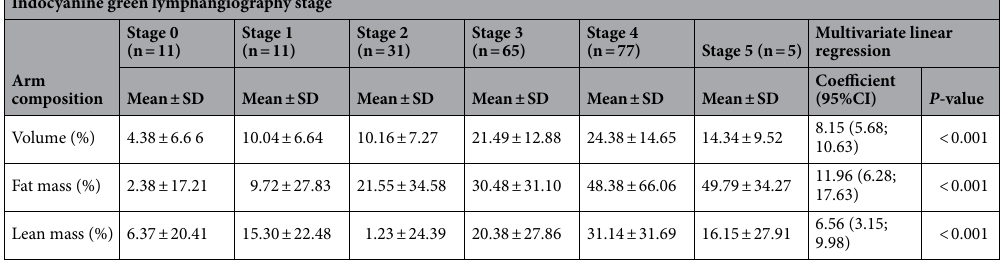
Table 3. Indocyanine green lymphangiography stage and excess volume, fat mass, and lean mass. This table shows the association between lymphangiography lymphedema stage and excess volume, fat mass, and lean mass. The multivariate regression model was adjusted for age, BMI, arm dominance, lymphedema duration, and lymphedema latency. N = number of patients at each stage. SD standard deviation.